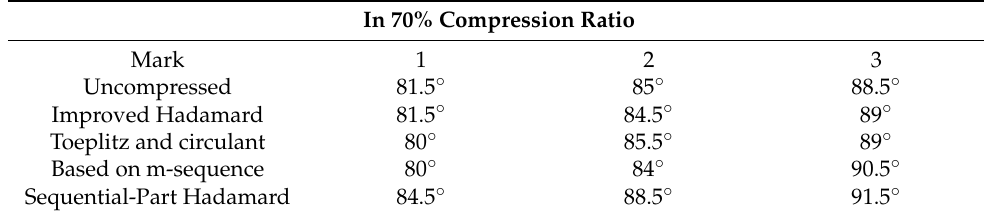
inhibitory effect on interference. Table 3. The angle of a mark in 70% Compression